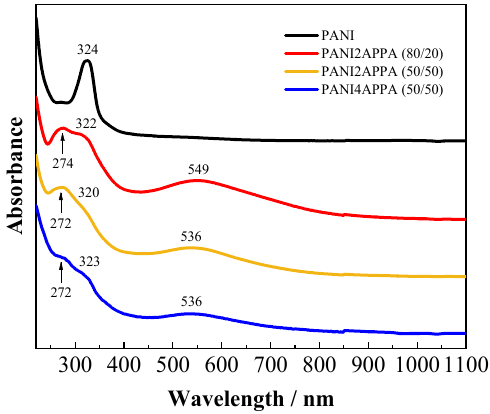
Figure 5. UV-Vis spectra of PANI (black line), PANI2APPA feed ratio 80/20 (red line) and 50/50 (orange line), and PANI4APPA feed ratio 50/50 (blue line) in a 1 M NH 4 OH solution.